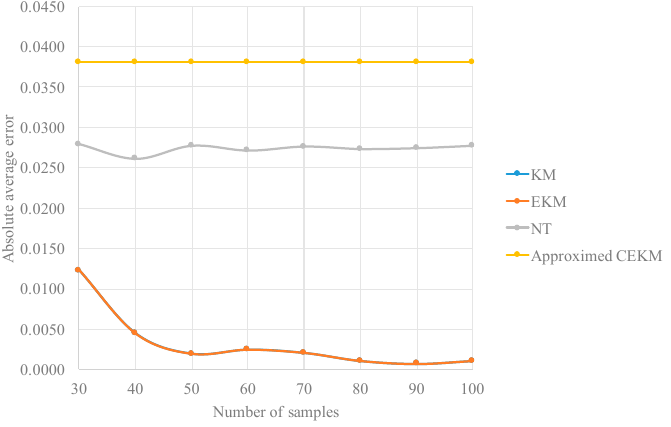
Figure 8. Average error comparison of the type-reduction algorithms.